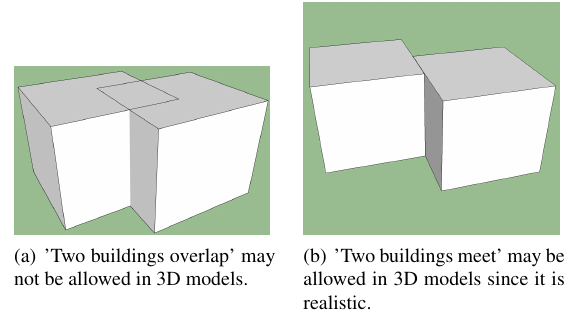
Figure 2: Details within non-disjoint can lead to serious discus- sion about validity of 3D model.